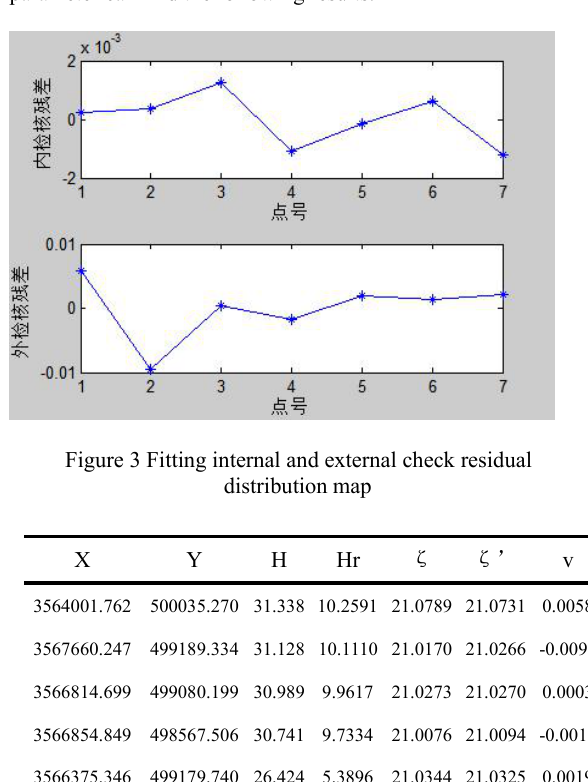
Table 7 RMSq, Cp, and AIC values for all possible regressions of the